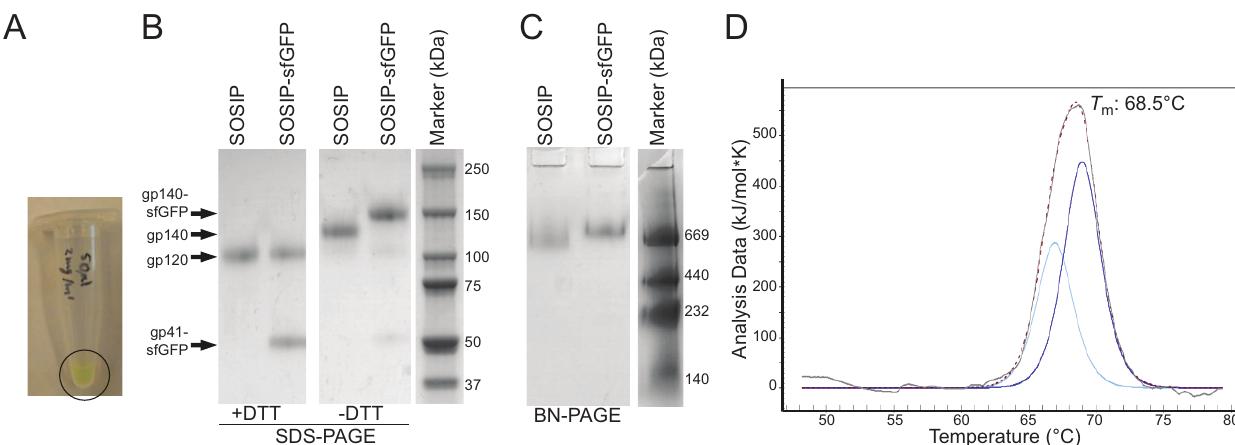
Figure 2. Purification and biochemical characterization of SOSIP-sfGFP. ( A ) Image of an Eppendorf tube containing PGT145-purified SOSIP-sfGFP (2 mg/mL); ( B ) Coomassie-stained reducing and non-reducing SDS-PAGE gels showing SOSIP and SOSIP-sfGFP, both purified with a PGT145-affinity column; ( C ) Coomassie-stained BN-PAGE gel of the same samples shown in B; ( D ) Melting curve of SOSIP-sfGFP obtained by DSC. The raw data is depicted in grey, while the fitted curve, from which the T m was derived, is depicted with a dotted line. Deconvolution of the unfolding profile using a non-two state model revealed two peaks, shown in light and dark